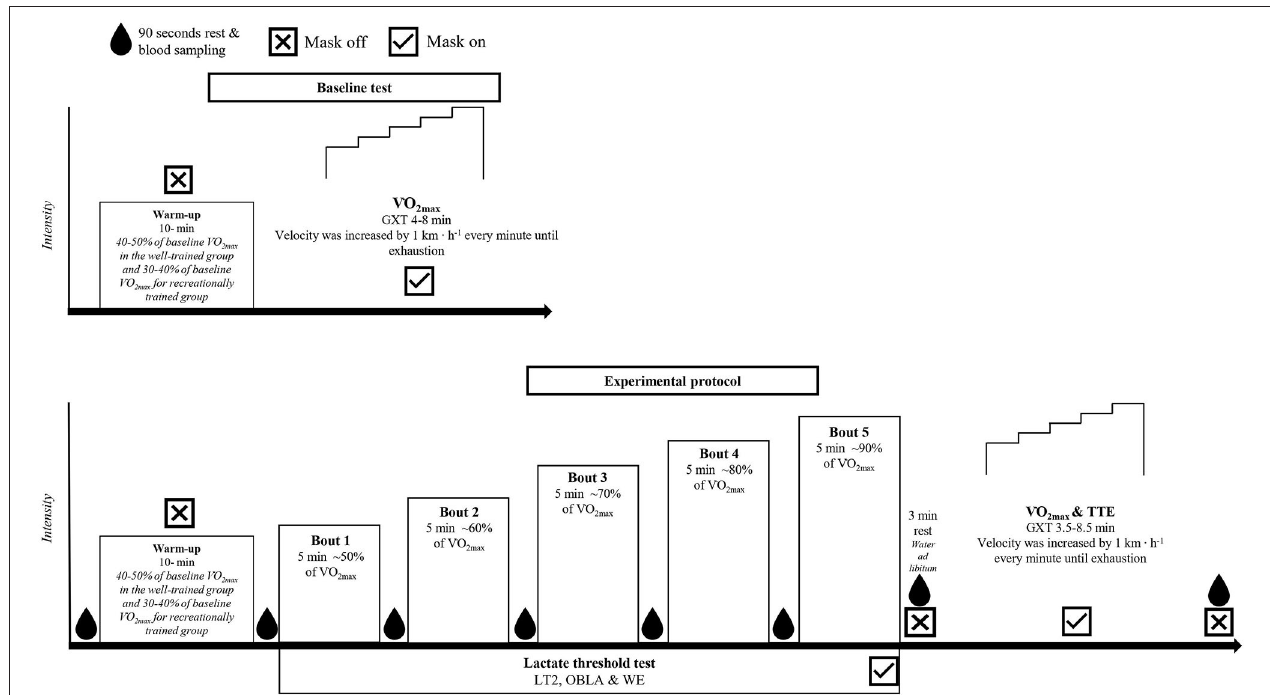
FIGURE 1 | Study design illustrating the initial baseline test and the experimental protocol for the three trials. ˙VO 2max , maximal oxygen uptake measured at the baseline test; GXT, graded exercise test; LT2, lactate threshold; OBLA, onset of blood lactate accumulation; WE, work economy; TTE, time to